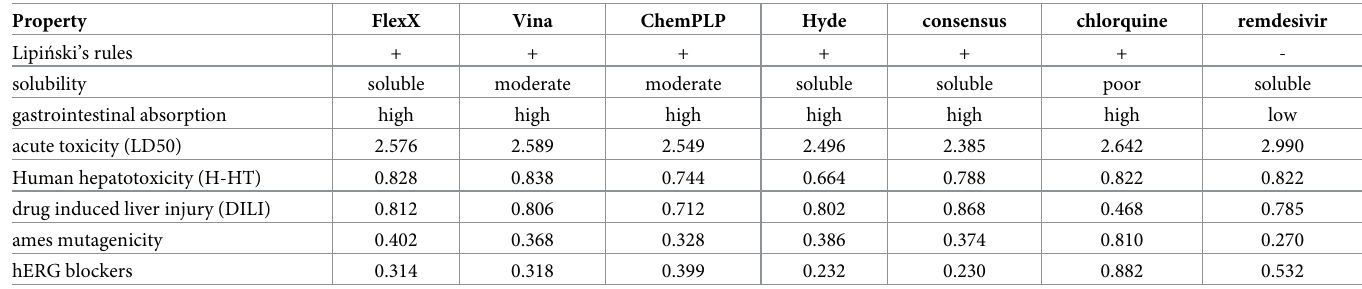
with grid optimization of the most important hyperparameters listed in Table 3. The R^2 on Table 2. ADMET properties of best results of docking in comparison to clinically tried drugs. Property